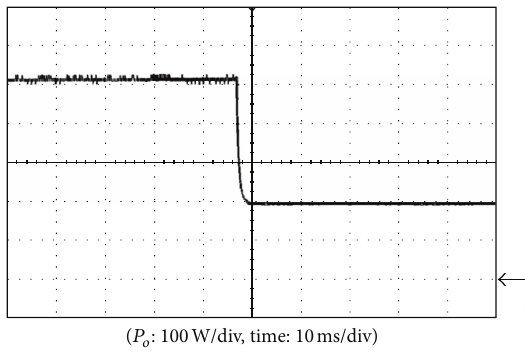
Figure 27: Output power variation while wind turbine shuts down from the hybrid generation